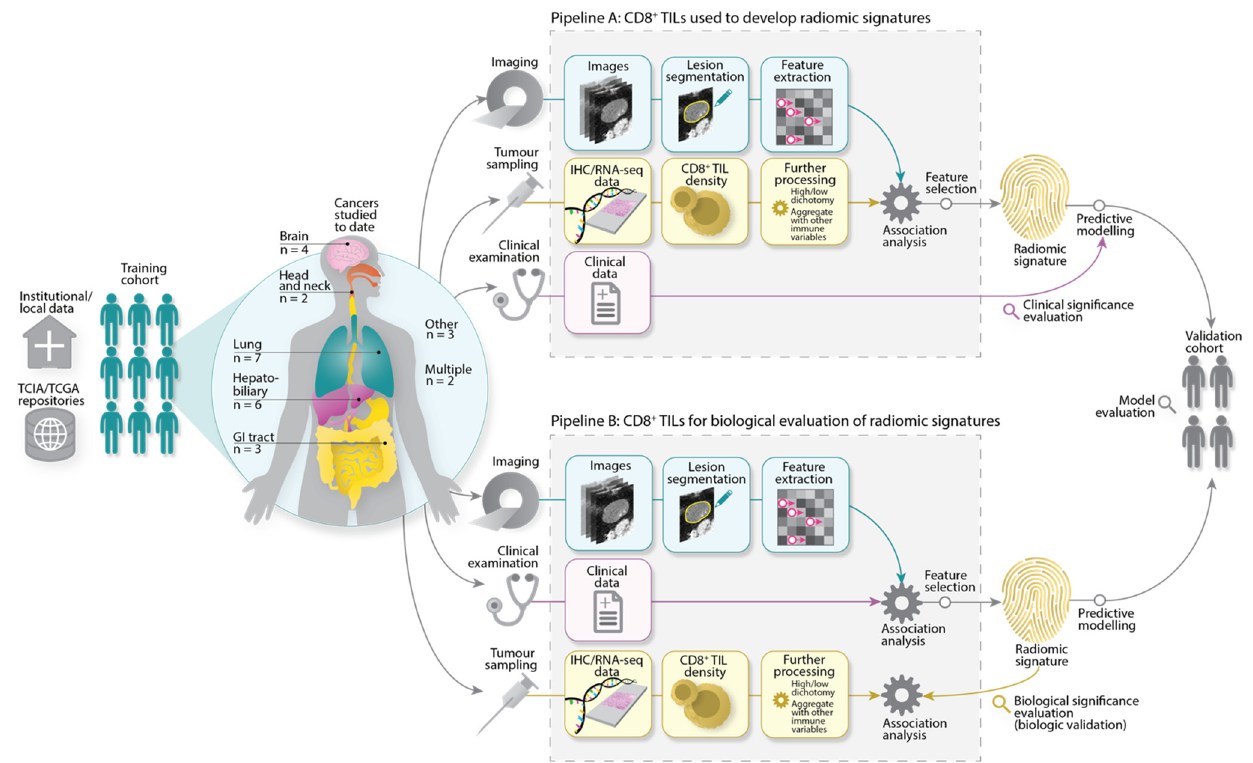
Figure 4. Radiomics workflow typically seen in the included studies. Imaging, biological, and clinical data were sourced from institutions and/or public repositories, before being subjected to further processing. To develop radiomic signatures, Pipeline A describes the main approach taken in the reviewed studies. Here, radiomic features were directly analysed for their association with CD8 + TILs. Features associated with CD8 + TILs were retained for radiomic signature derivation, model construction, and further evaluation. Pipeline B describes an alternate pathway where radiomic signatures were first developed by assessing the association of features with clinical variables, e.g., objective response. Signatures were then evaluated for their association with CD8 + TILs to explain, at least partially, the biological basis of the radiomic signatures. Acronyms: TCIA/TCGA = The Cancer Imaging Archive/The Cancer Genome Atlas, IHC = immunohistochemistry, RNA-seq = RNA sequencing.